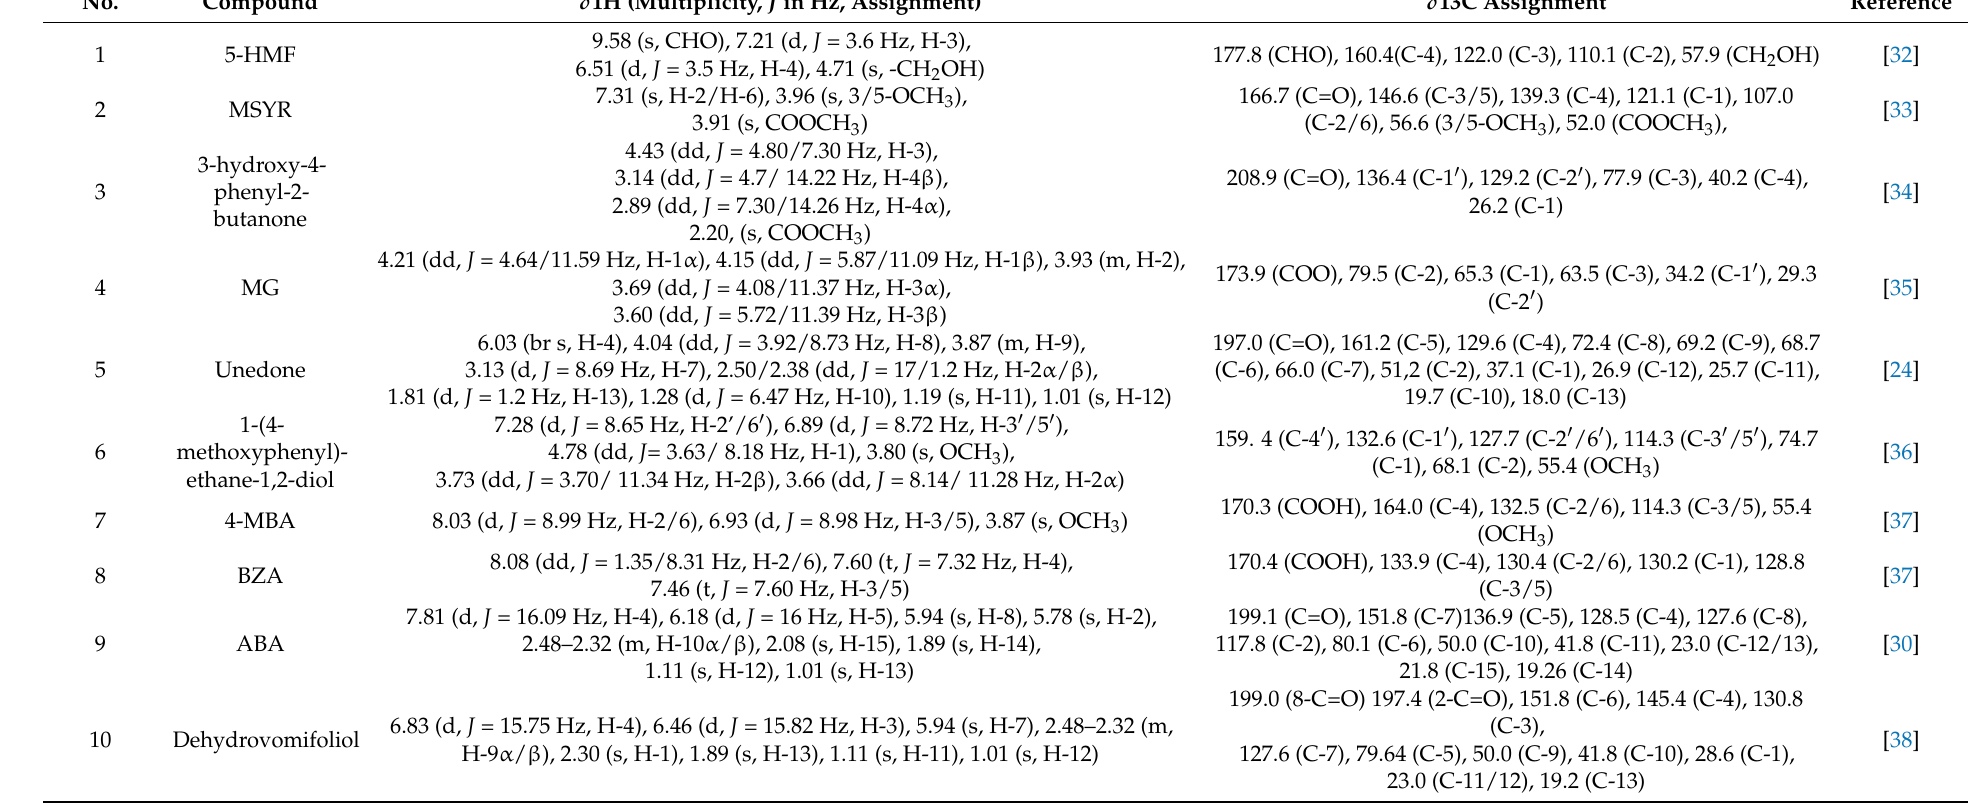
Table 2. 1 H NMR spectroscopic data (600 MHz; chloroform- d ) of identified compounds in honey